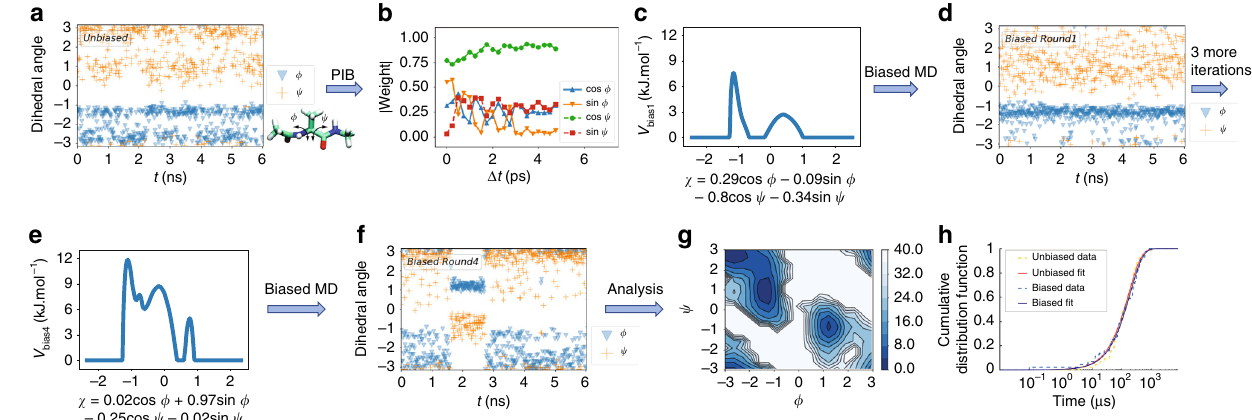
Fig. 2 Past – future information bottleneck framework results on alanine dipeptide. a Unbiased simulation trajectory for dihedral angles Φ and Ψ , in blue triangles and orange pluses, respectively. The alanine dipeptide molecule is shown in inset. b Absolute weights for different order parameters in the fi rst training round as a function of the predictive time delay Δ t . Blue triangles, orange triangles, green circles, and red squares correspond to cos ϕ , sin ϕ , cos ψ , and sin ψ , respectively. c – f Free energy along the adaptively learnt reaction coordinate (RC) along with the corresponding biased trajectories for different training rounds. g Free energy along ϕ , ψ after the RC has converged with energy contours every 4 kJ mol − 1 . h Kinetics from the post-training biased runs as well as reference unbiased runs. The two are essentially indistinguishable. Orange and blue dashed lines denote unbiased data, respectively, while red and black solid lines show corresponding best fi